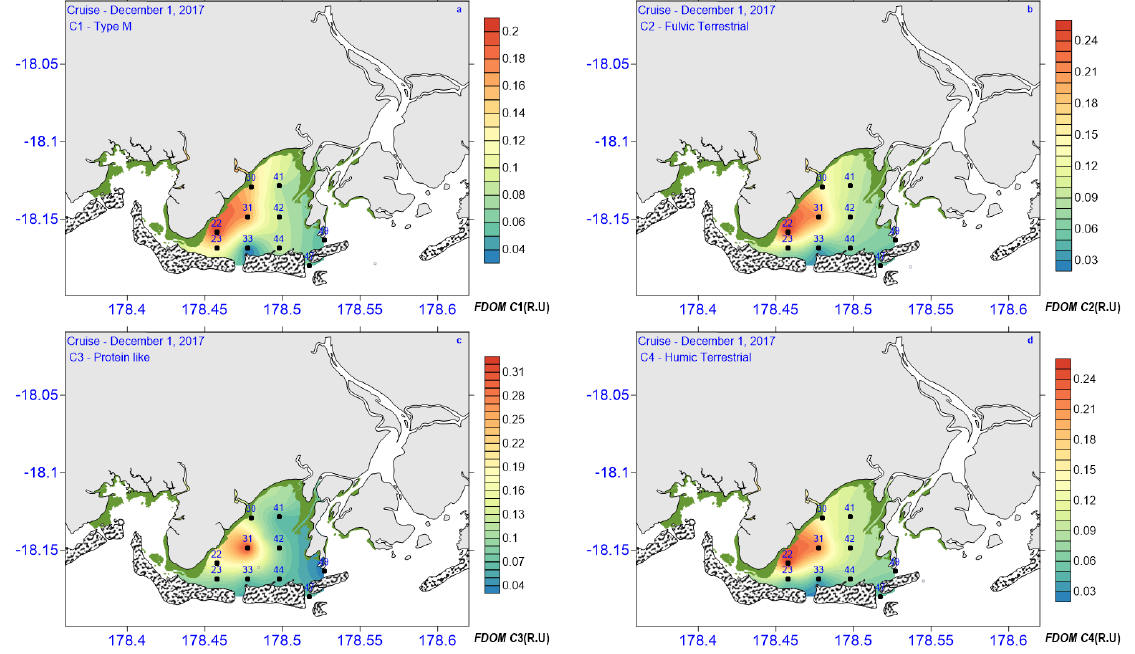
Figure 8. Color maps for components: ( a ) C1—Type M; ( b ) C2—Fulvic Terrestrial; ( c ) C3—Protein–like and ( d ) C4—Humic Terrestrial.